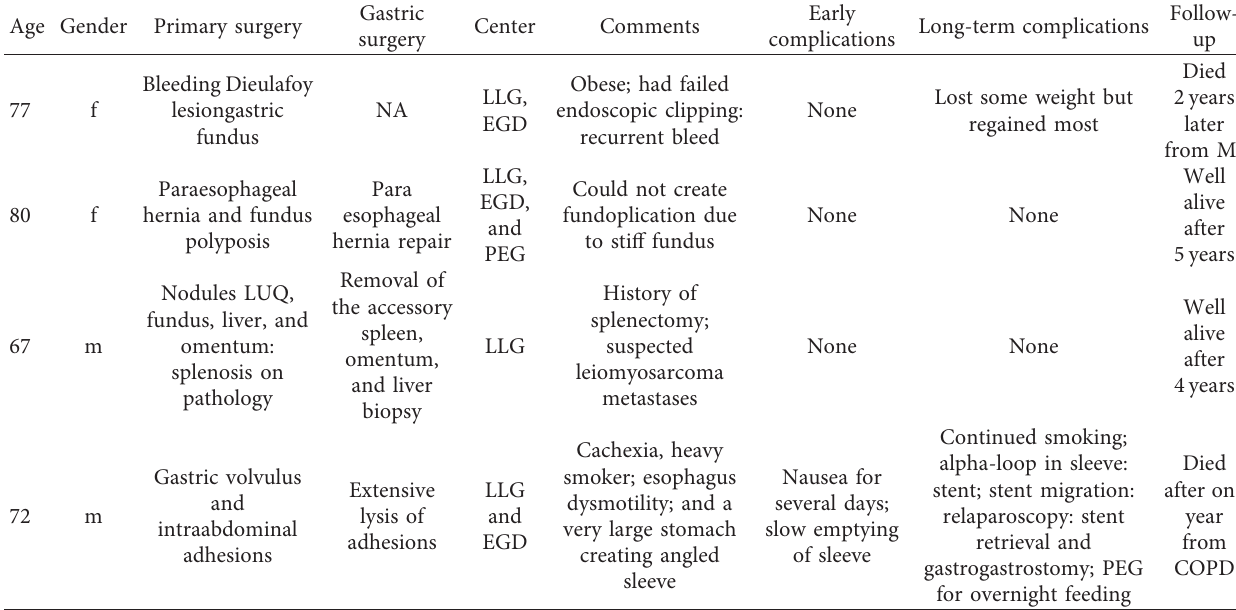
Table 1: Demographic and clinical